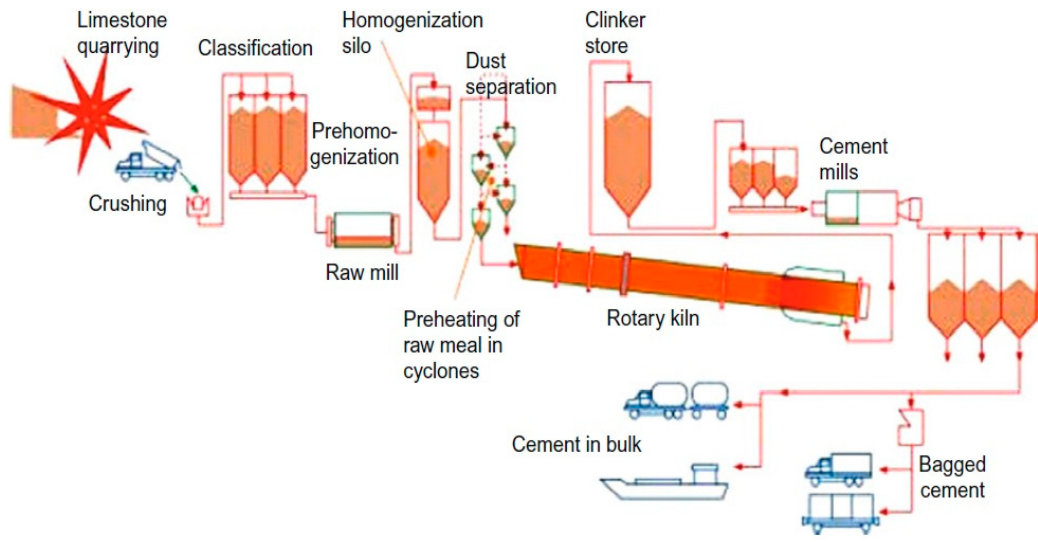
Figure 1. Cement manufacturing process [8].